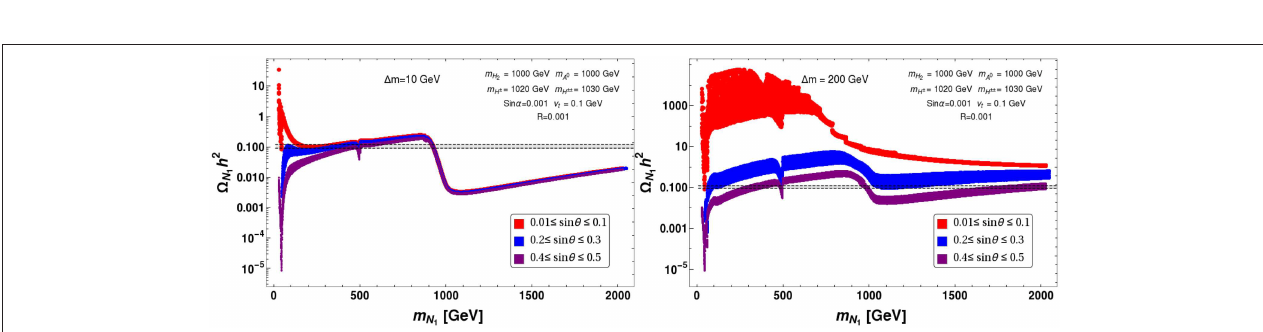
FIGURE 26 | Variation of relic density with DM mass m N scalar triplet. Different color patches correspond to different sin θ region : 0.01 (cid:127) h 2 density, 0.1166 0.1206 is shown by black dashed line. All the masses are in GeVs. ≤ ≤